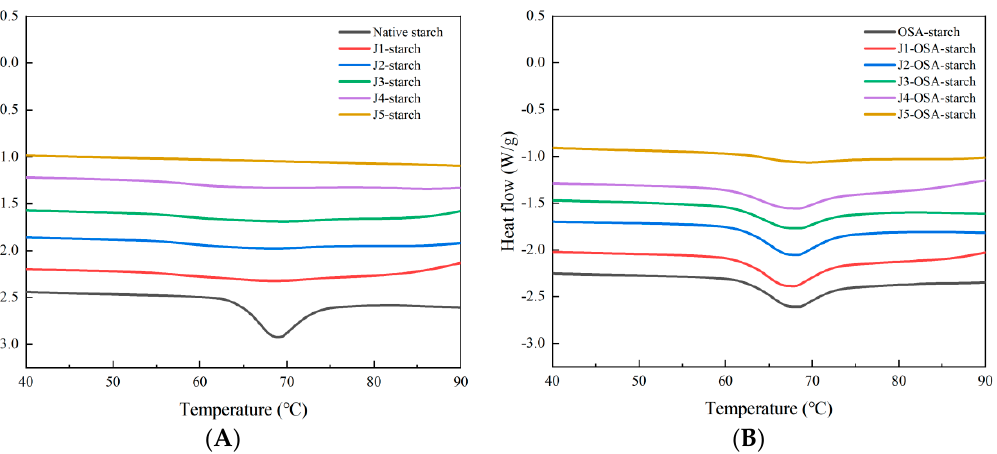
Figure 6. DSC spectra of J-starch and J-OSA-starch : ( A ), DSC spectra of J-starch; ( B ), DSC spectra of J-OSA-starch. Table 3. DSC analysis of the native and treated corn starch samples.